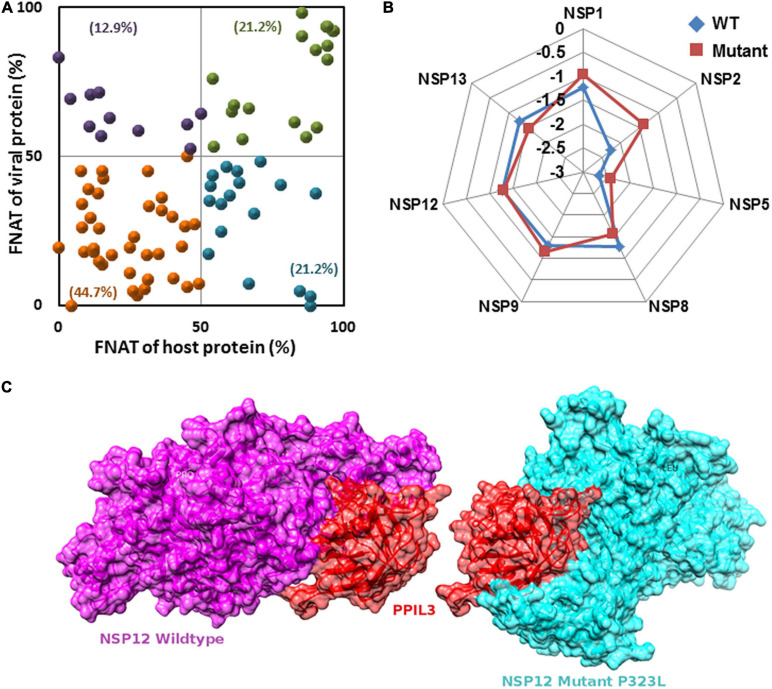
(A) Fraction of conserved native contacts (FNATs) of non-structural protein (NSP)–host protein–protein interactome (PPI) complexes formed by the mutant NSPs were calculated with respect to the complexes formed by the wild-type (WT) NSPs. FNAT for both human and viral proteins are plotted. Green, purple, orange, and blue points indicate mutant NSP–human PPI complexes with FNAT values in quadrants I, II, III, and IV, respectively. Percentage values show frequency of each quadrant FNAT complex. (B) The percentage of total energy deviation before and after 100 ns of molecular dynamics (MD) simulation in WT and mutants NSP complexed with partner human proteins. (C) An example where host protein peptidyl-prolyl isomerase like-3 (PPIL3) (red) has a different binding site for wild-type NSP12 (purple) and mutant (P323L) (cyan) sharing only 18% common residues at the interface.